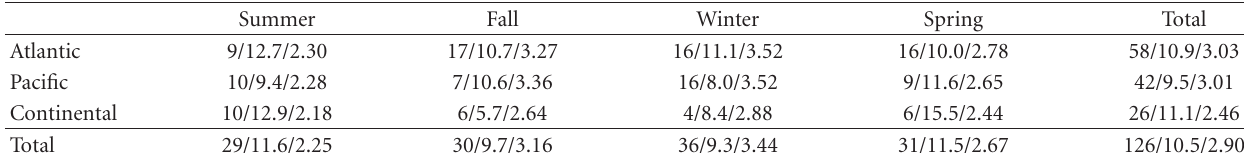
Table 2: A summary of the occurrence and character of the blocking events for the calendar years 2002–2004. Blocking parameters in each cell are blocking events/durations (days)/BI.